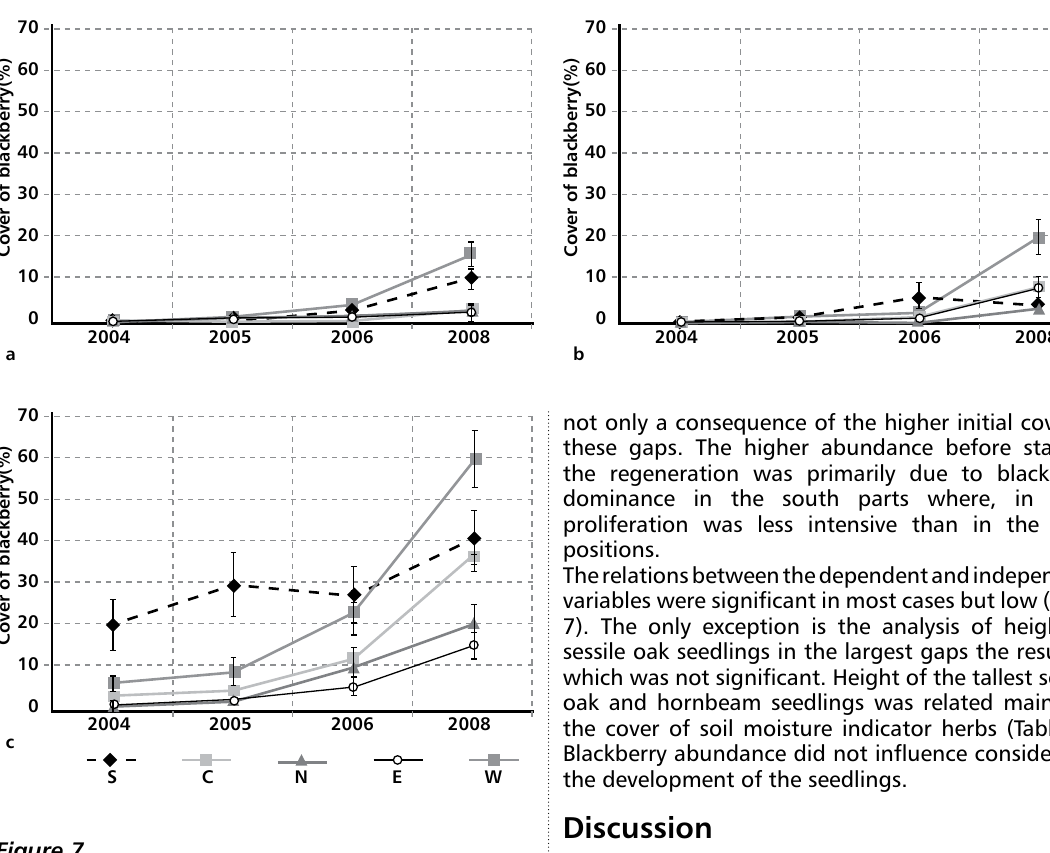
Spread of blackberry in gaps of 15 m (a), 30 m (b) and 45 m (c) in diameter. For results of significance tests, see Table 6. The legend is shown on Figure 7a. Explanations are given at Table 1 and Figure 2.